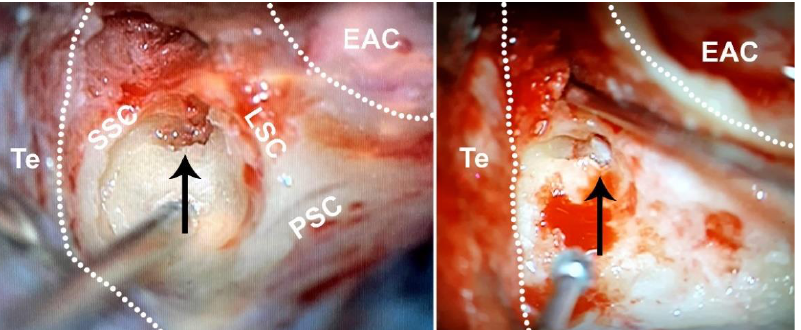
Figure 1. The adult bony labyrinth, right ear. Adult vestibular specimens were collected from the opened semicircular canals (black arrow, left panel) and after further drilling of the vestibulum (black arrow, right panel). EAC, external auditory canal. LSC, lateral semicircular canal. PSC, posterior semicircular canal. SCC, superior semicircular canal. Te, tegmen. Human fetal inner ear samples of 14 weeks fetal age were collected after elective ter- mination of pregnancy by vacuum aspiration. Fetal age (in weeks, W), defined as the du- ration since fertilization, was determined by obstetric ultrasonography prior to termina- tion, with a standard error of two days. Samples were transported in DMEM/F-12, sup- plemented with 0.5× N2, 0.5× B-27 (minus vitamin A) and Normocin (100 µg/mL), and dissected directly upon arrival in the laboratory using a Leica M205C dissecting micro- scope. After removing the bony capsule and identifying the otolith organs, ampullas, and the cochlear duct, the endolymphatic compartment was opened to expose the sensory do- mains (Figure 2C – E). A total of three complete fetal utricles and three basal turns of fetal cochleas were used.